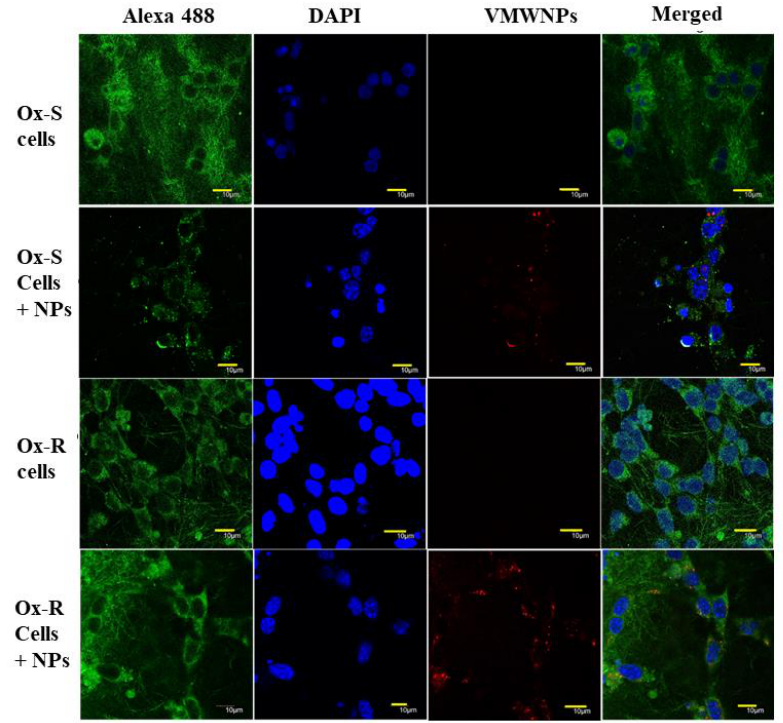
Figure 3. CLSM images of OxS and OxR CT-26 CRC cells with internalization with VMWNPs. Alexa 488 indicates cell cytoskeleton and DAPI indicates the nuclei.